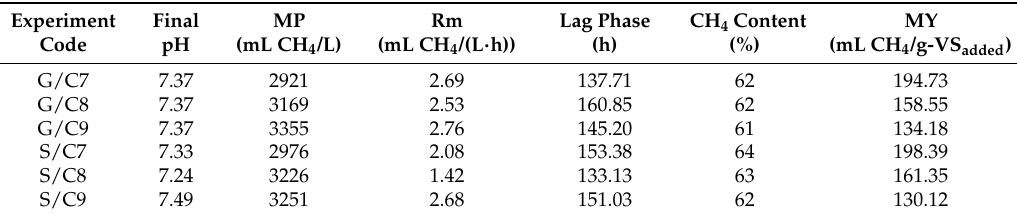
Table 3. MP, methane content, Rm and MY from a co-digestion of Napier grass with cow dung and silage with cow dung by